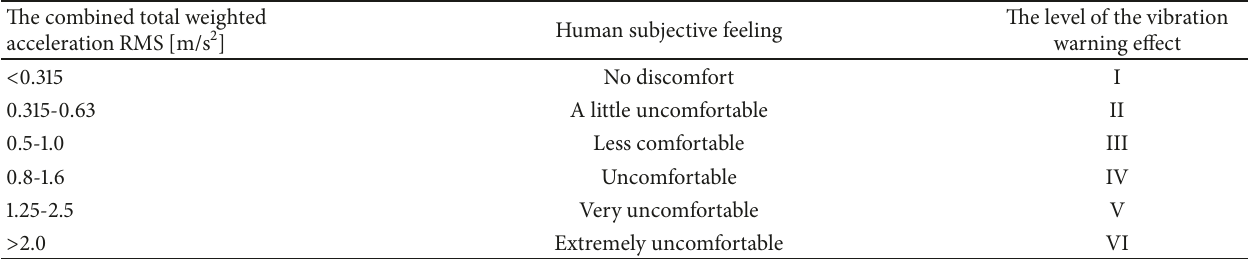
Table 3: The relationship between the human subjective feeling and the combined total weighted acceleration RMS. The combined total weighted